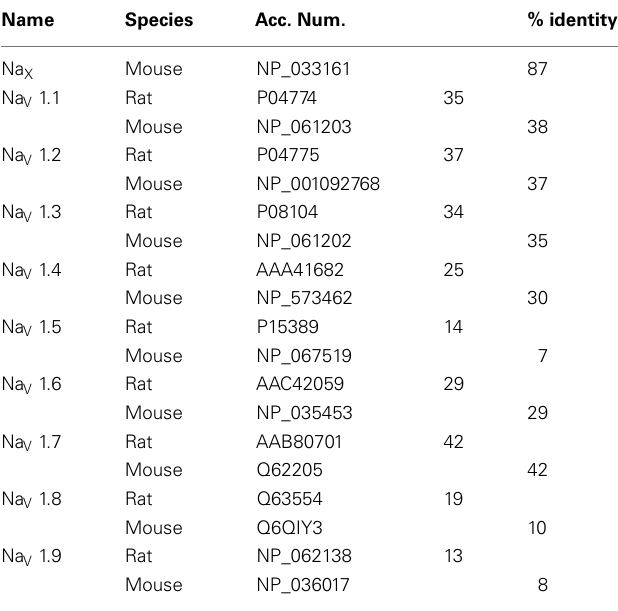
Table 2 | Percentage of identity between the rat Na X antibody epitope used in this study, the mouse Na X and the voltage-gated Na V sodium